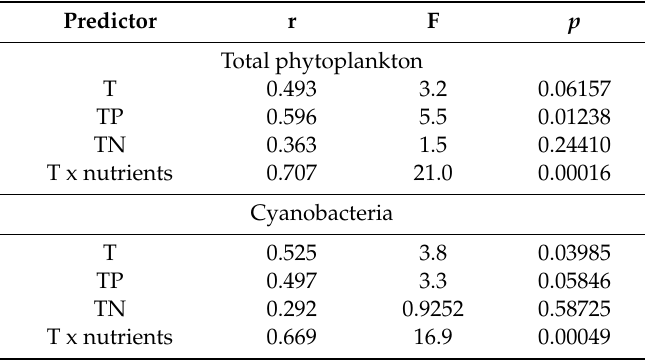
Table 2. Generalized additive models for total phytoplankton and cyanobacteria response to environmental variables.